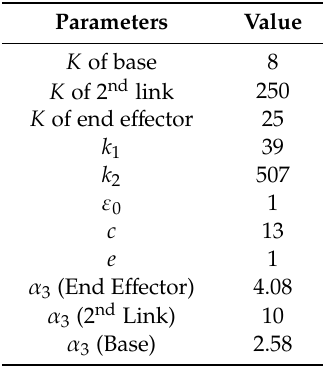
Figure 11. Error between the end effector trajectories for master and slave. The estimated perturbations for the master’s and slave’s end effectors are presented in Figures 12 and 13, respectively. The maximum value of estimated perturbation for the master system was 90.87 N·m at 178.01 s, whereas for the slave system, this was 1635.72 N·m at 148.016 s.